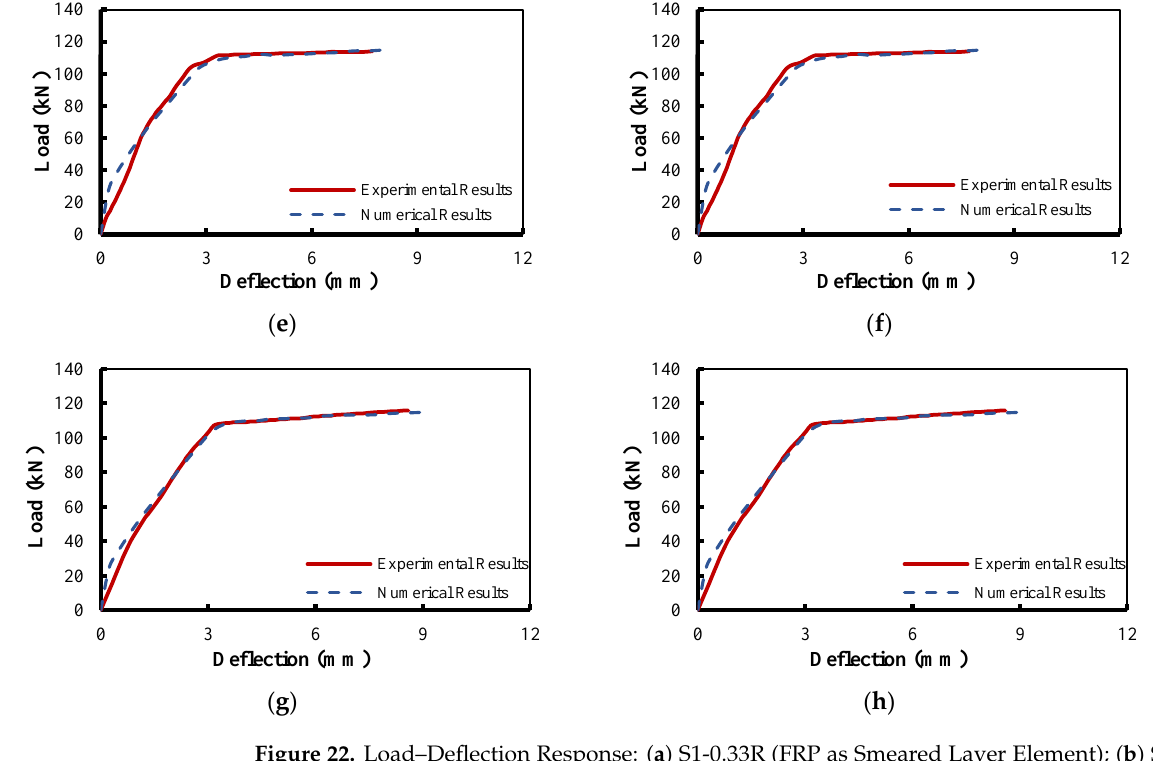
Figure 22. Load–Deflection Response: ( a ) S1-0.33R (FRP as Smeared Layer Element); ( b ) S1-0.33R (FRP as Discrete Truss Element); ( c ) S3-EB (FRP as Smeared Layer Element); ( d ) S3-EB (FRP as Discrete Truss Element); ( e ) FB30-2 (FRP as Smeared Layer Element); ( f ) FB30-2 (FRP as Discrete Truss Element); ( g ) FB30-3 (FRP as Smeared Layer Element); ( h ) FB30-3 (FRP as Discrete Truss Element). Table 6. Comparison between Smeared Layer and Discrete Truss Elements to Model FRP Composites.